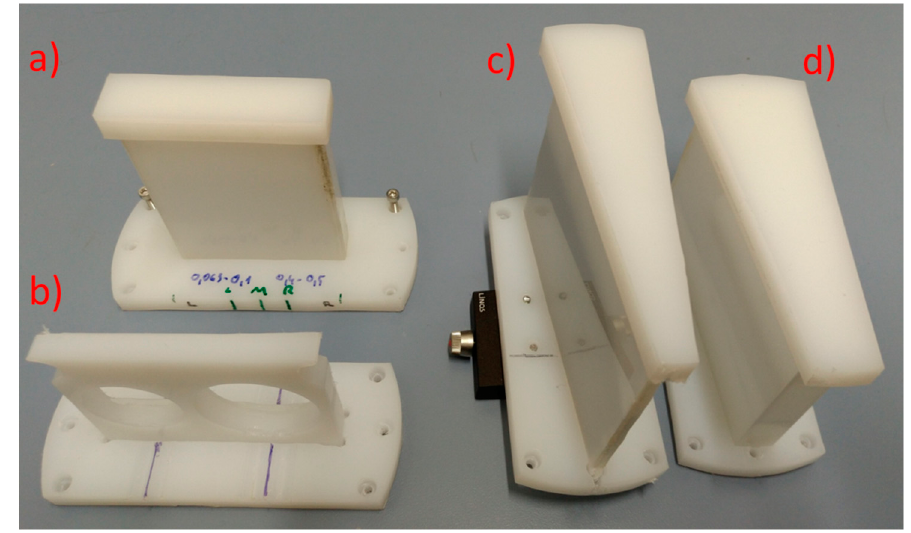
Figure 1. High-density polyethylene (HDPE) sample holders: ( a ) rectangular shape; ( b ) dish holder; and ( c , d ) wedge shape.